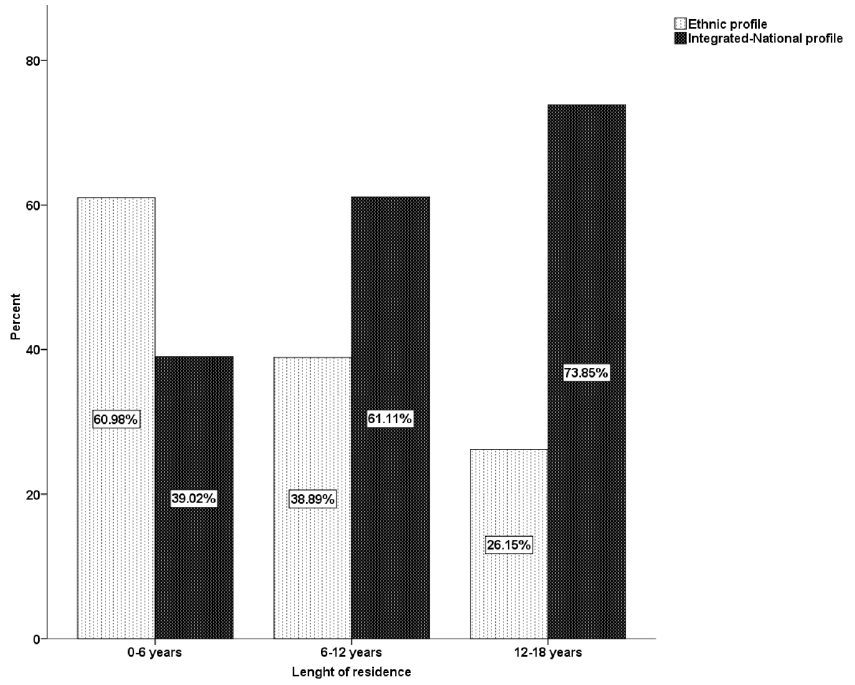
Figure 1. Acculturation profiles by length of